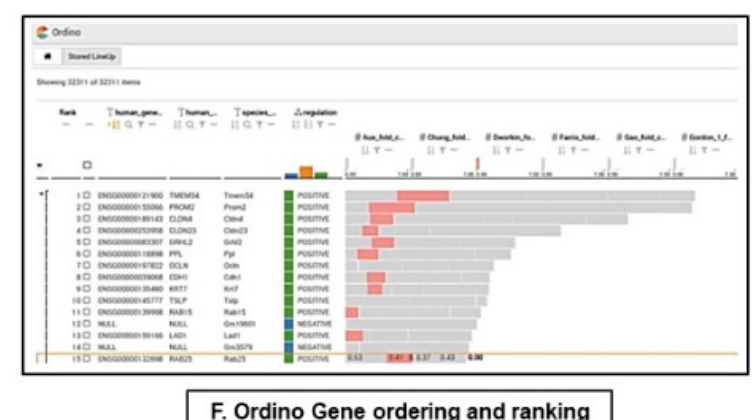
Figure 1. Meta-analysis pipeline methodology All published grh / Grhl Microarray / RNA-SEQ datasets were converted to a common file format (.csv, A ) and imported into MySQL ( B ). Next, we determined whether genes within each dataset were positively or negatively regulated following functional modulation of grh / Grhl ( C ), and genes across the datasets were ranked according to their regulation within each dataset. To achieve a common gene ranking, the fold change rank-based scores from individual datasets were aggregated into the sum of scores for each gene, separately for positively and negatively regulated genes. ( D ). Each gene symbol within all datasets was mapped to the appropriate gene using Ensembl. After mapping, a table of all the human-mapped data was generated, searchable by the original gene symbol in every species ( E ). For interactive visualization and exploring, the data were exported from the MySQL database, re-structured and uploaded into Ordino ( F ).